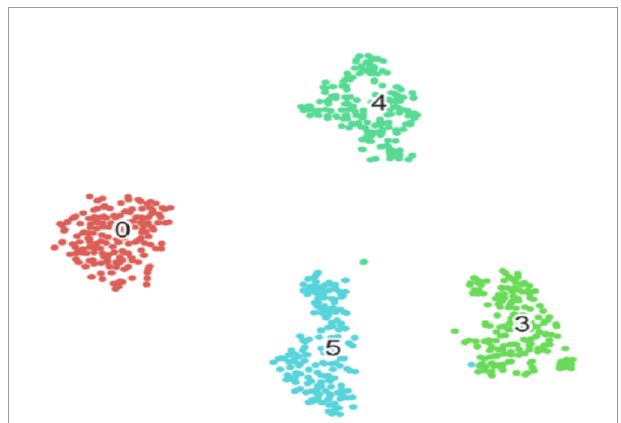
FIGURE 4 | Our proposed method for T-SNE visualization with four-Gleason grading, where 0 represents benignity and 3, 4, and 5 represent Gleason grading 3, 4, and 5,